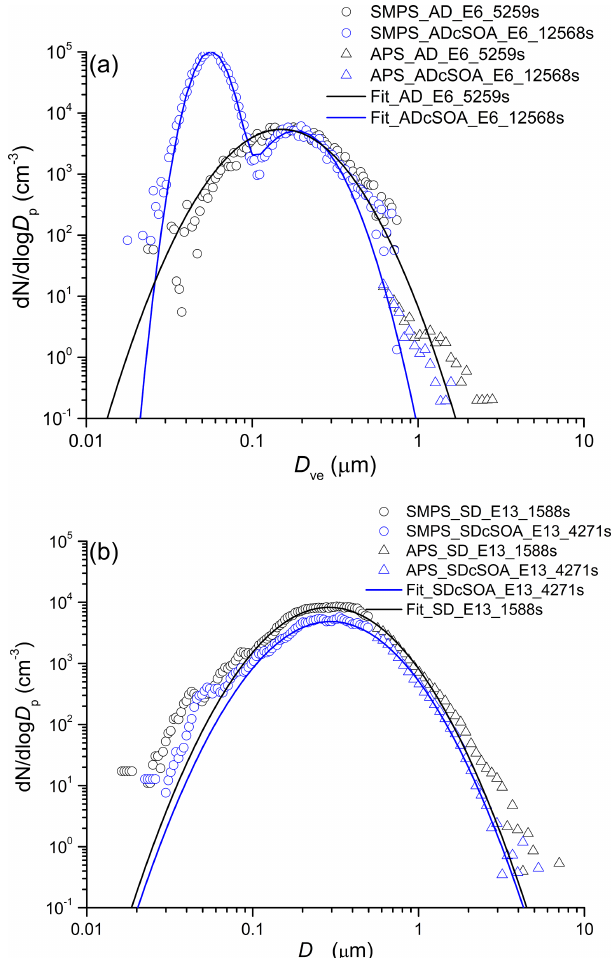
Figure 2. Exemplary number size (volume-equivalent diameter) distribution of AD (a) and SD (b) samples before and after coat- ing with α -pinene SOA. Nucleation of pure SOA particles results in the bi-modal distribution after SOA coating, giving rise to the mode at